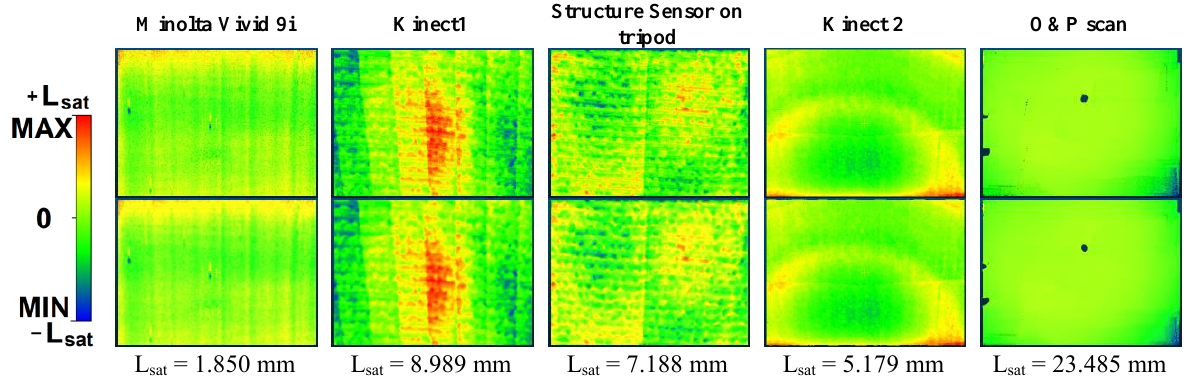
Figure 2. Comparison of the results on the flat plane the different devices, organized by column, in respect to an ideal plane. The first row regards the models without the filter, thus showing the global error. The second row contains the results after the application of the Taubin filter, that show the systematic error. Notice that the colour scale is the same in the column but different between the devices, and the colour saturation limits are indicated below with a single value, since the scale is